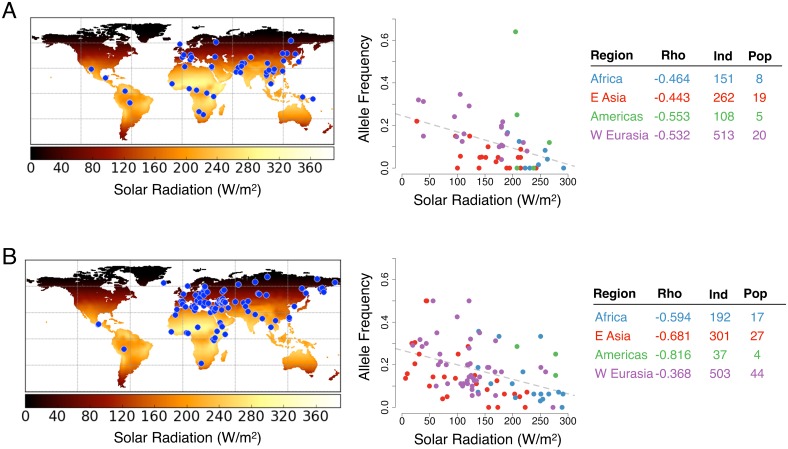
Testing se-eQTLs for signs of local adaptation.Environmental correlations with allele frequency in (A) HGDP populations and (B) Lazaridis et al [62] populations. Left panels: Heatmap of the environmental variables used in the study. Units are Watts per meter squared. Populations are marked with blue circles. Note that three of the American populations from Lazaridis et al. (Mixe, Mixtec, and Zapotec) [62] are marked in the same geographic location. Right panels: Radiation level vs allele frequency of the population for the RASSF9 se-eQTL (rs11117173) with the color indicating the regional subgroup. For each regional subgroup, the Spearman correlation (Rho), the number of individuals (Ind), and the number of populations (Pop) are provided in the table.